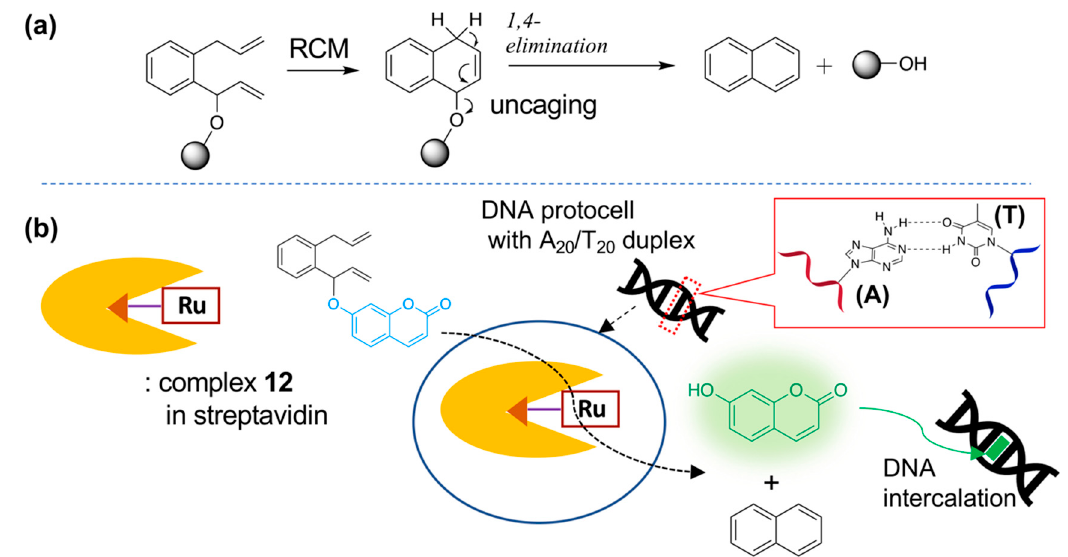
Figure 7. Metathesis-induced uncaging and its application for hybrid OM-ArM with complex 12 in DNA protocells [39]; ( a ) Mechanism of uncaging induced by ring-closing metathesis (RCM) reaction; ( b ) Streptavidin-based ArM with complex 12 in a DNA protocell.